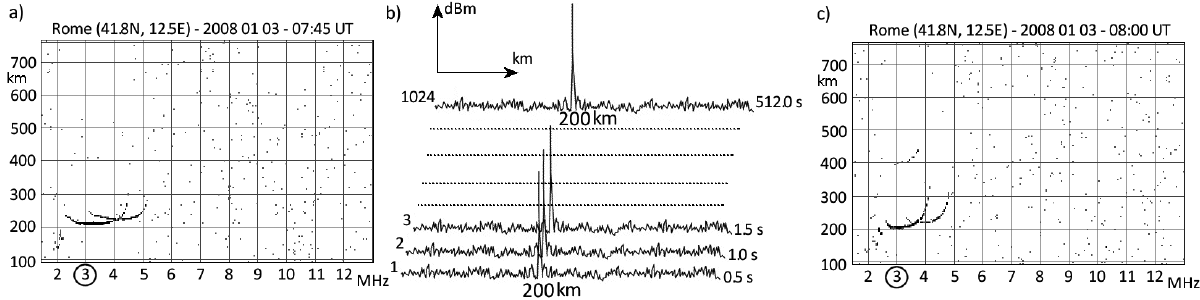
Figure 1. Ionograms recorded by VIS (a) before and (c) after the (b) PVH measurements of the received echo every 0.5 s at the frequency f = 3.0 MHz - highlighted by an open circle in (a) and (c). The ionogram sounding repetition rate is 15 minutes. The PVH measurement ses- sion lasts 512 s, which corresponds to 1024 samples of PVH.